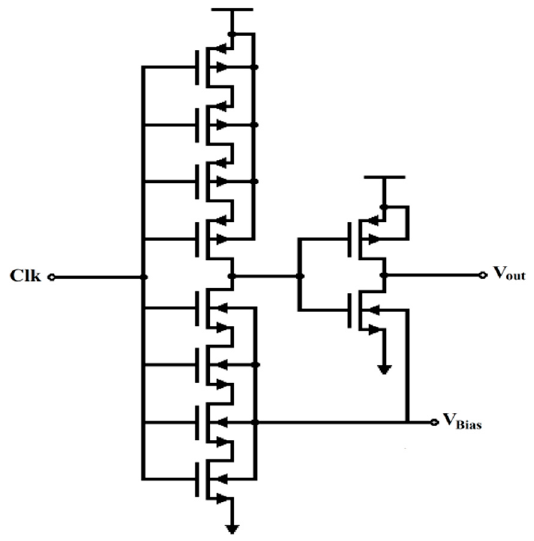
Figure 22. Vernier delay-line time-to-digital converter (TDC).